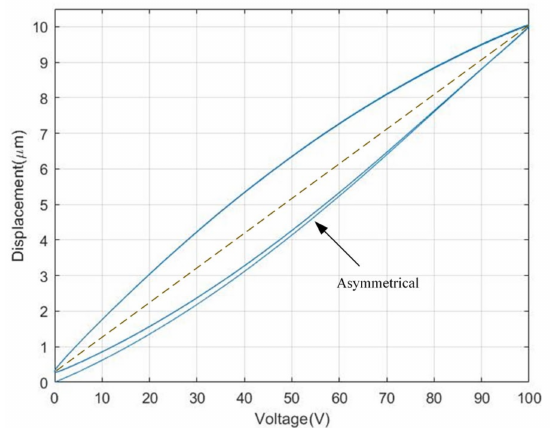
Figure 1. Measured hysteresis loop of a PZA.